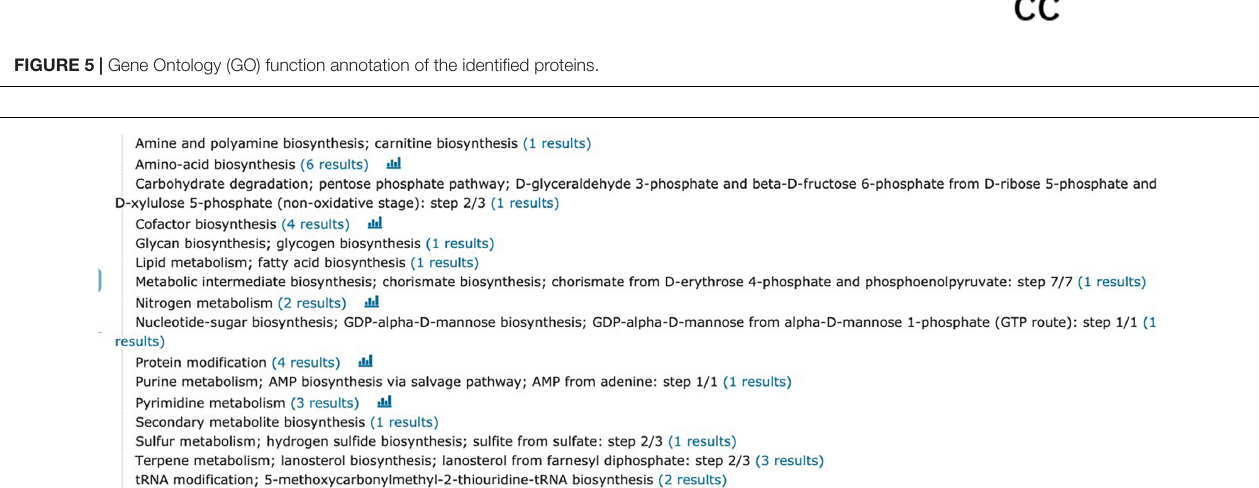
FIGURE 6 | Kyoto Encyclopedia of Genes and Genomes (KEGG) pathway